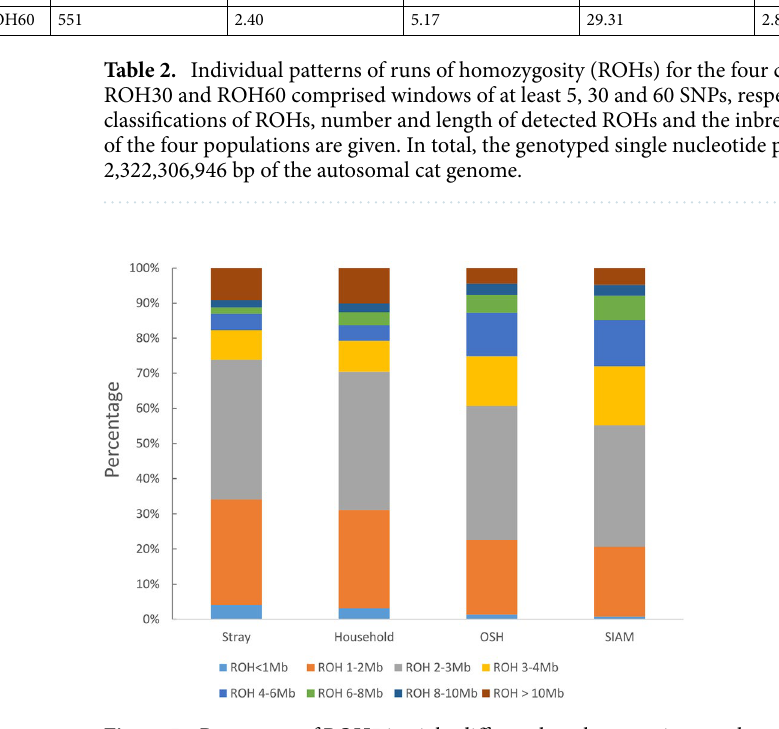
Figure 5. Percentage of ROH5 in eight different length ranges in stray, household, OSH and SIAM. The calculation was based on individual patterns of ROHs, i.e. the total number of ROHs for individuals in a population.